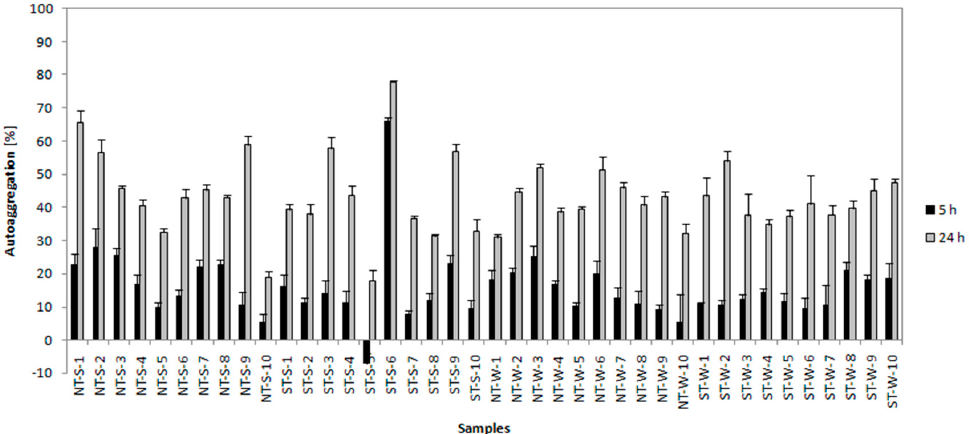
Figure 5. Autoaggregation (%) of tetracycline-resistant isolates from the wastewater treatment plant measured at 600 nm after 5-h and 24-h incubation at 30 ◦ C. Samples defined as weak autoaggregative measured at 600 nm after 5-h and 24-h incubation at 30 °C. Samples defined as weak autoaggregative ( < 20%) and strong autoaggregative ( > (<20%) and strong autoaggregative (>70%).